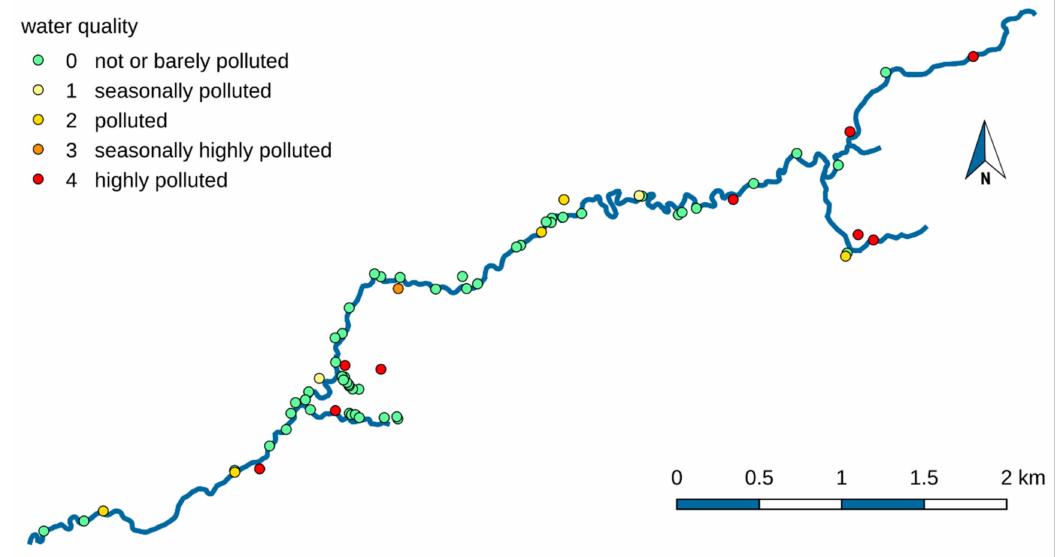
Figure 3. Location of photographs indicating degree of pollution of the Pochote River based on field survey information